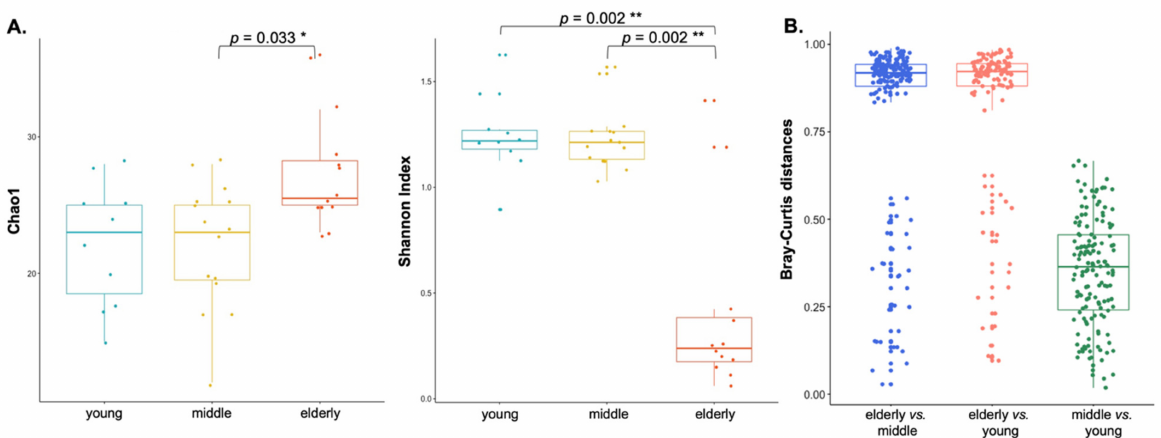
Figure 5. Comparisons of alpha and beta diversities in all three age groups. ( A ) Alpha diversity was measured in terms of Chao1 and Shannon indexes among the three age groups, as a qualitative trait (Dunn test, Bonferroni adjusted p -value). ( B ) Bray–Curtis distances show significant differences in the elderly vs. middle/young (two-tailed Student’s t -test using 10,000 Monte Carlo permutations, computed using QIMME’s script make_distance_boxplots.py). The central line shown in each box plot indicates the median of the data and the whiskers extend to cover the whole range of values. * p < 0.05 and ** p <